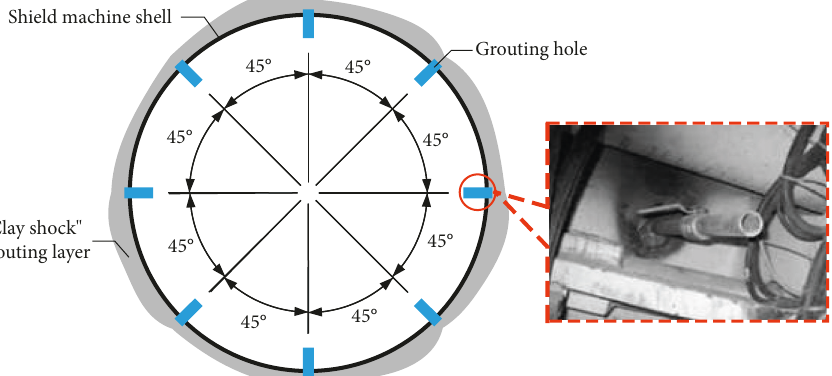
Figure 4: The layout of grouting holes in the shield machine